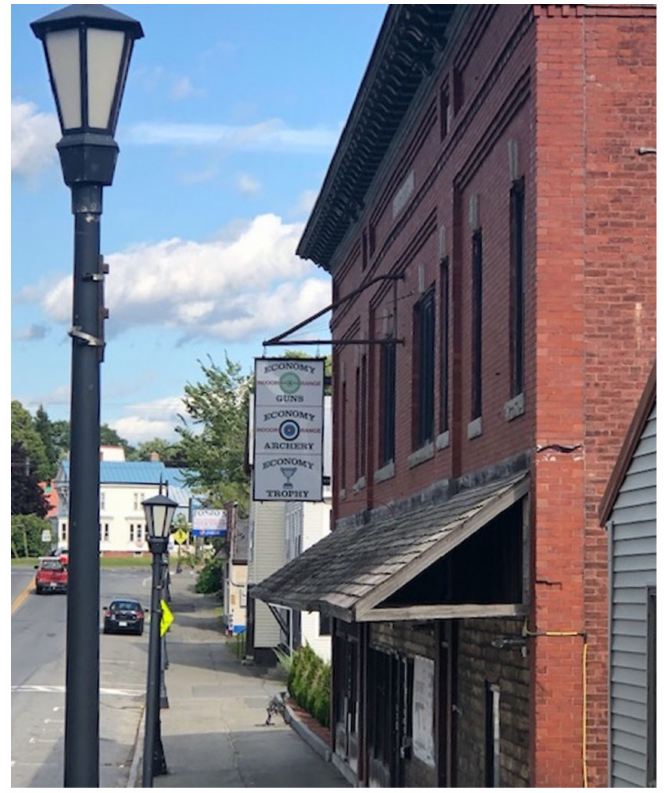
Figure 13. From transect across Central Maine: Stage 4–Recycling. Former bar now gun shop and shooting range in downtown Madison, Maine. (Photo courtesy of Betty